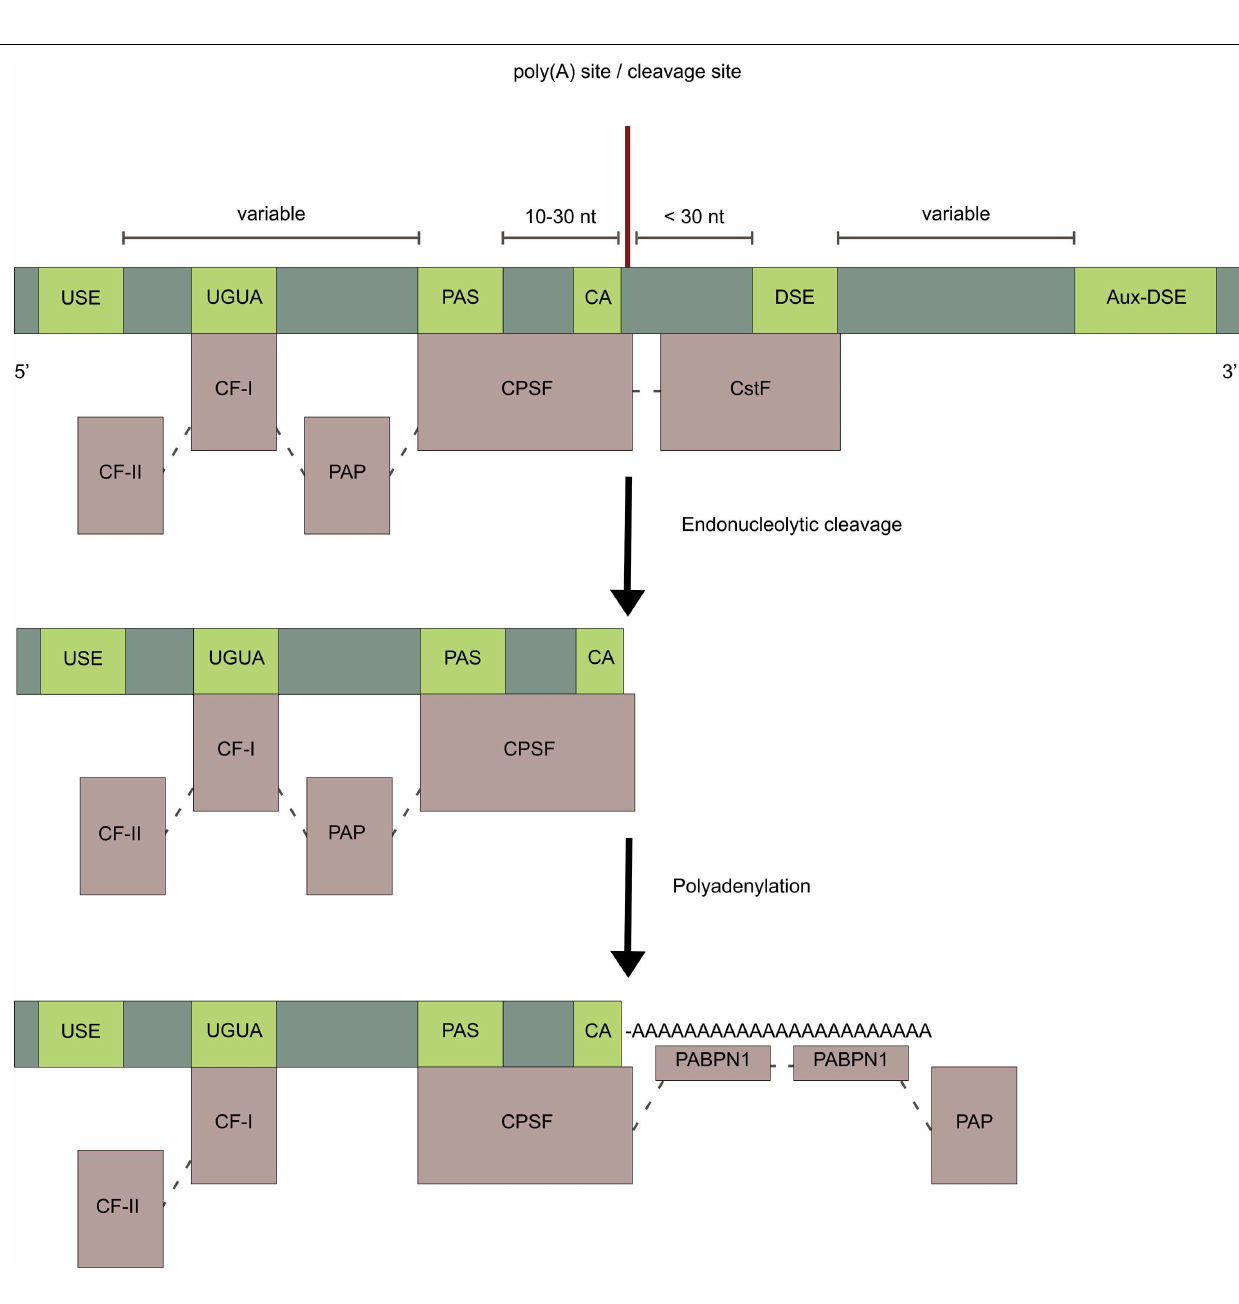
FIGURE 2 | Cis-elements and polyadenylation factors . Light-green boxes represent cis-elements in the pre-mRNA and light-purple boxes represent polyadenylation factors.The endonucleolytic cleavage of the pre-mRNA is made by the CPSF-subunit CPSF-73 at the poly(A) site, typically immediately